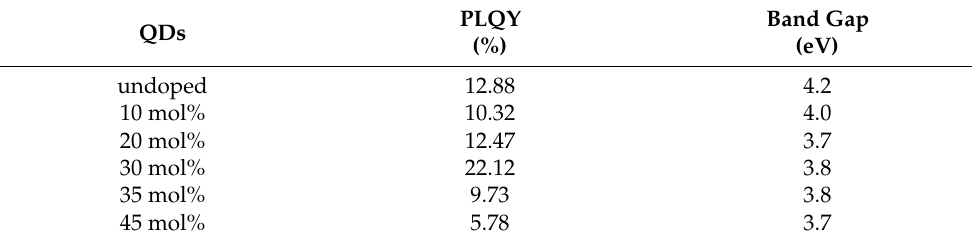
Figure 1. ( a ) Transmission spectrum of Cs 3 Bi 2 Cl 9 QDs and Cs 3 Bi 2 Cl 9 :Ce QDs; ( b ) photoluminescence spectrum of Cs 3 Bi 2 Cl 9 QDs and Cs 3 Bi 2 Cl 9 :Ce QDs with excitation wavelength of 375 nm. Table 1. Fluorescence information for samples.